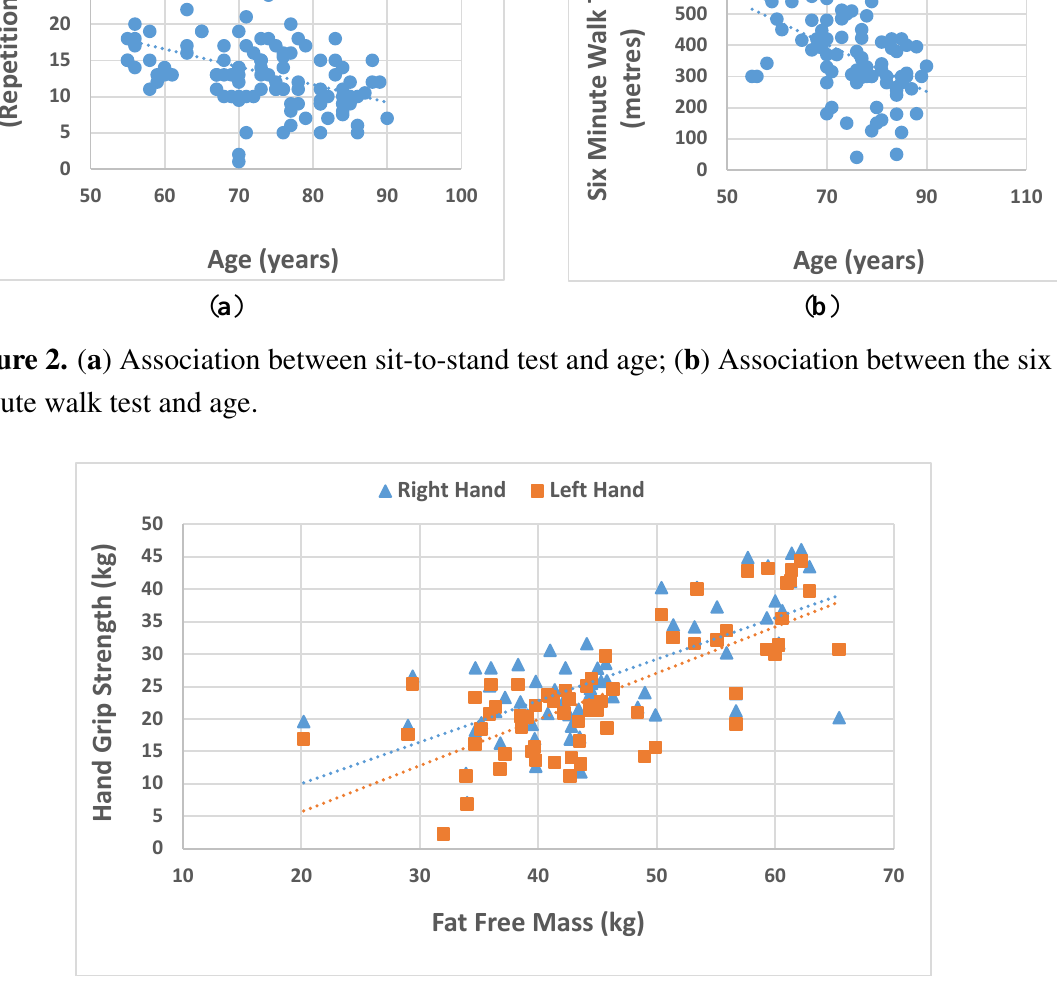
Figure 3. Association between right and left hand grip strength and fat free mass.